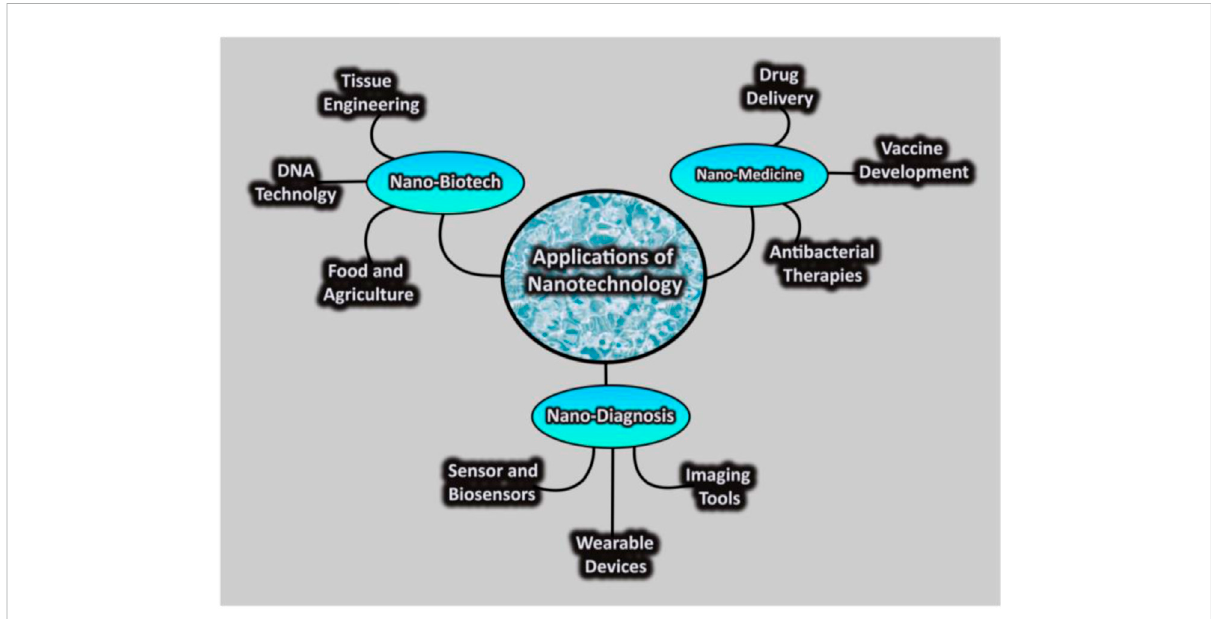
FIGURE 3 Schematic diagram of nanotechnology application in various fi